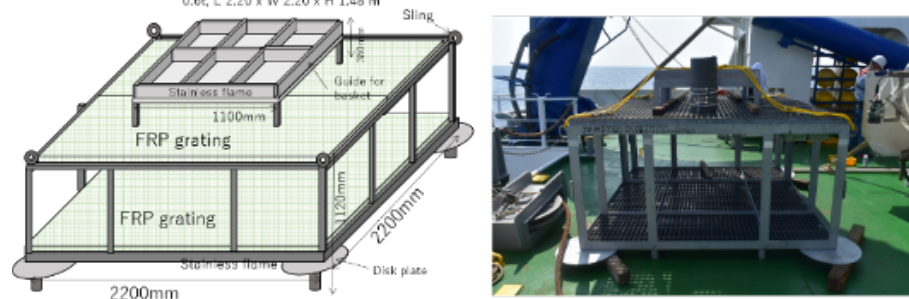
Figure 2. Concept (left) and image (right) of the